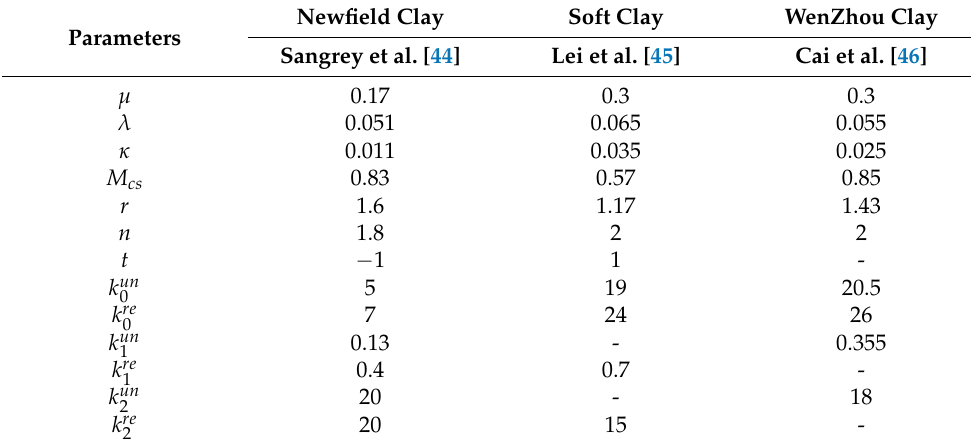
Table 1. Model parameters values.